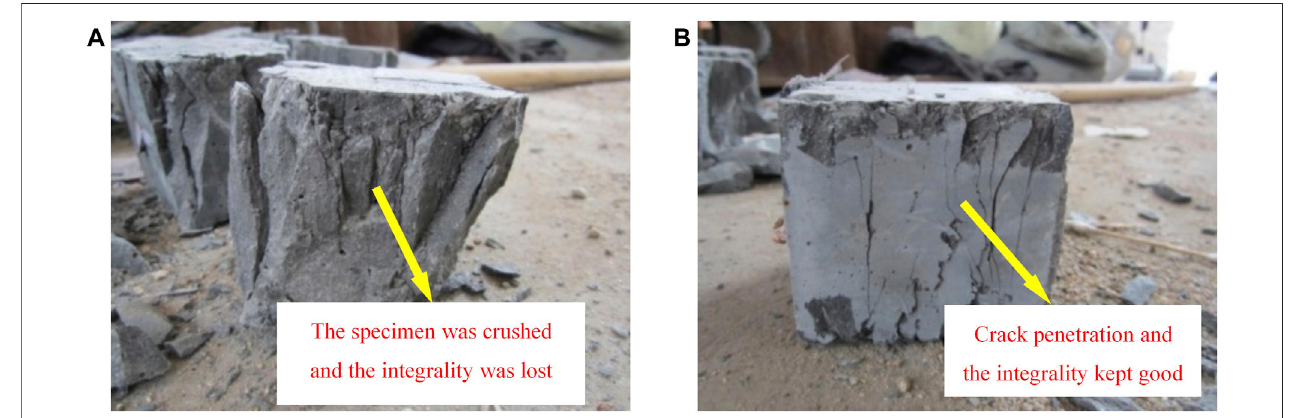
FIGURE 4 | Failure mode of specimen. (A) Failure mode of specimens without steel fi ber; (B) failure mode of specimens with steel fi ber.